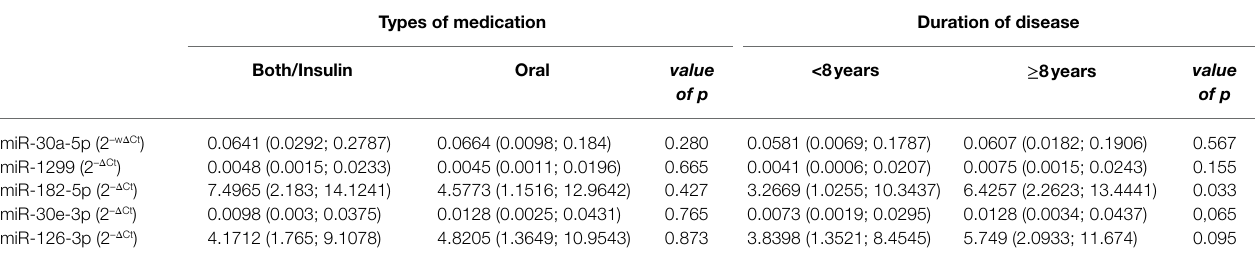
TABLE 2 | Comparisons between miRNA expression with treatment type and duration of